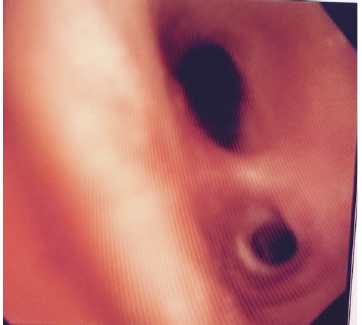
Figure 5: Abrupt end to whitish grey mucosa directly following